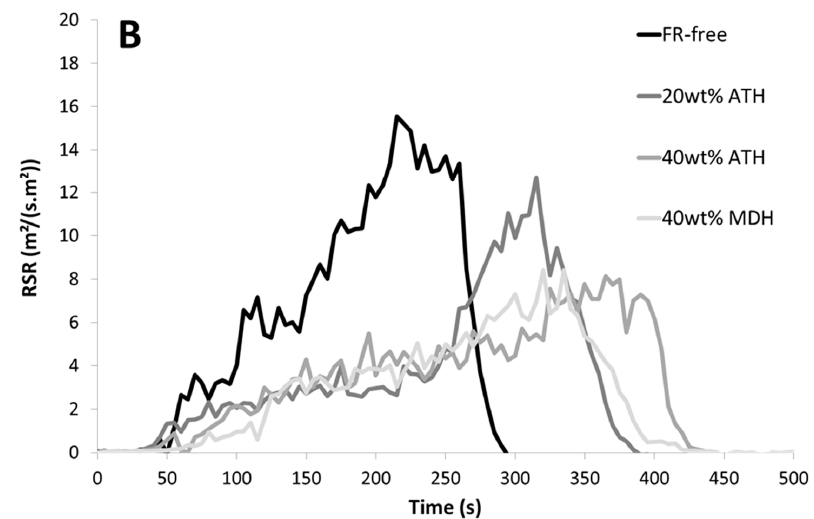
Figure 5. ( A )/HRR versus time in cone calorimeter (50 kW/m 2 ) for PE/EVA filled with ATH or MDH. ( B )/RSR versus time in cone calorimeter (50 kW/m 2 ) for PE/EVA filled with ATH or MDH.